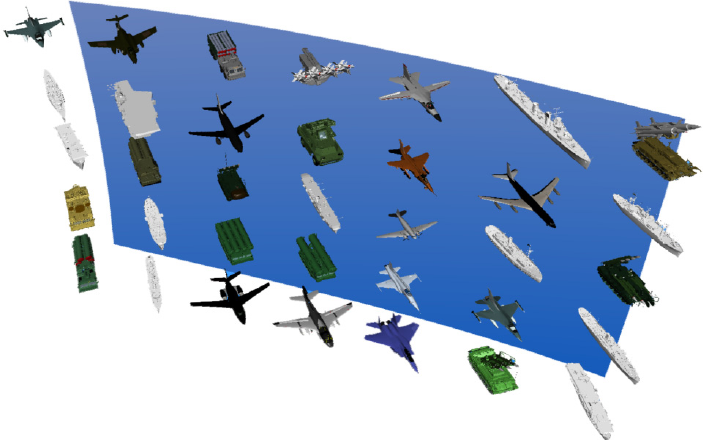
Figure 11. Information display layer of the depth distance experiment of situational awareness in- formation.